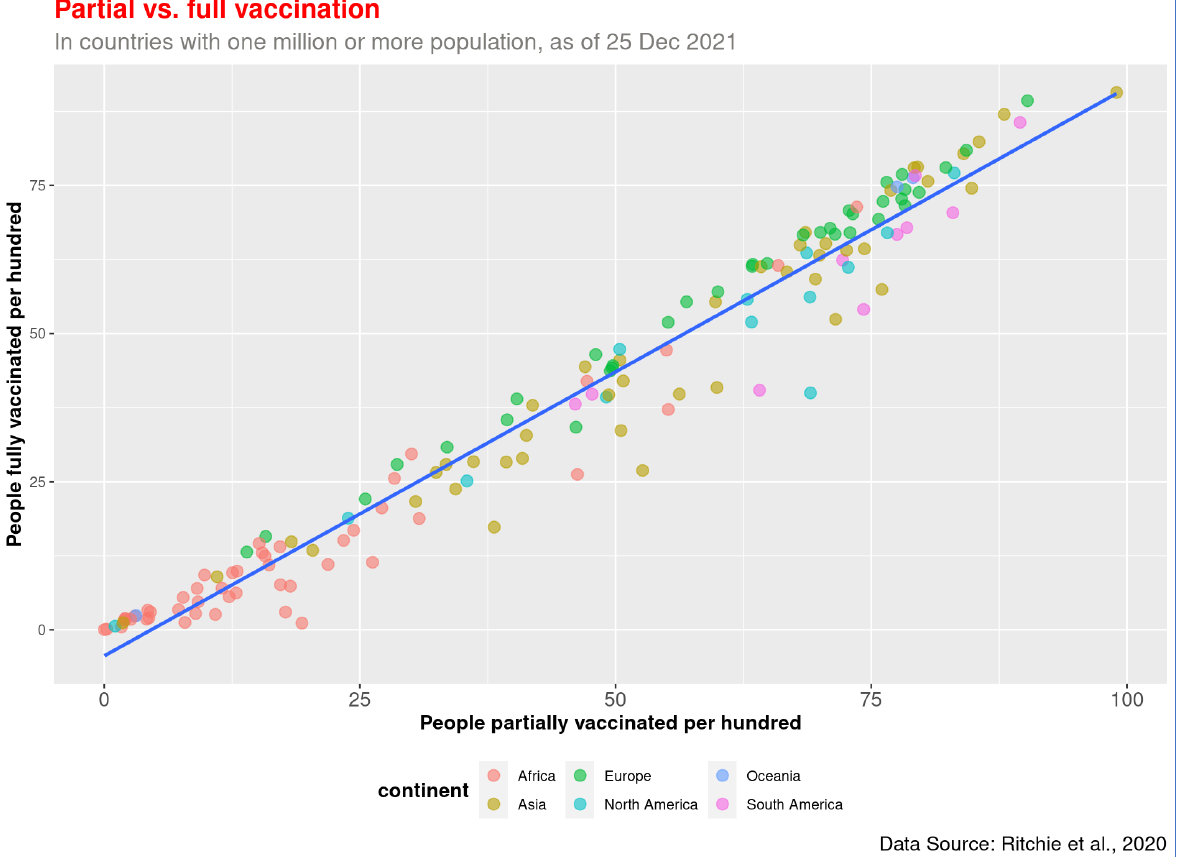
Figure 3. Association between partial and full vaccination. Countries that have achieved a higher level of partial vaccination also reached a higher full vaccination, and most African countries are on the lower left side of the graph. The global pattern of the association between GDP per capita and vaccination holds across continents (Figures 4 and 5). The richer the country, the higher the vaccination rate is in every continent. The wealthy countries in Europe, North America, and Asia managed to protect a higher proportion of the population with the vaccine. As shown in Figures 4 and 5, African countries have the lowest income. Except for a few, such as Mauritius and Morocco, all other countries in that continent are lagging in COVID-19 vaccination.